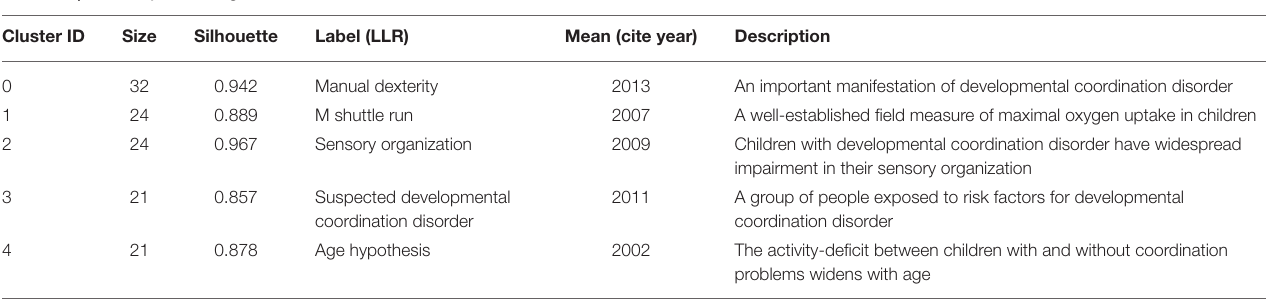
TABLE 4 | Summary of the largest five clusters.